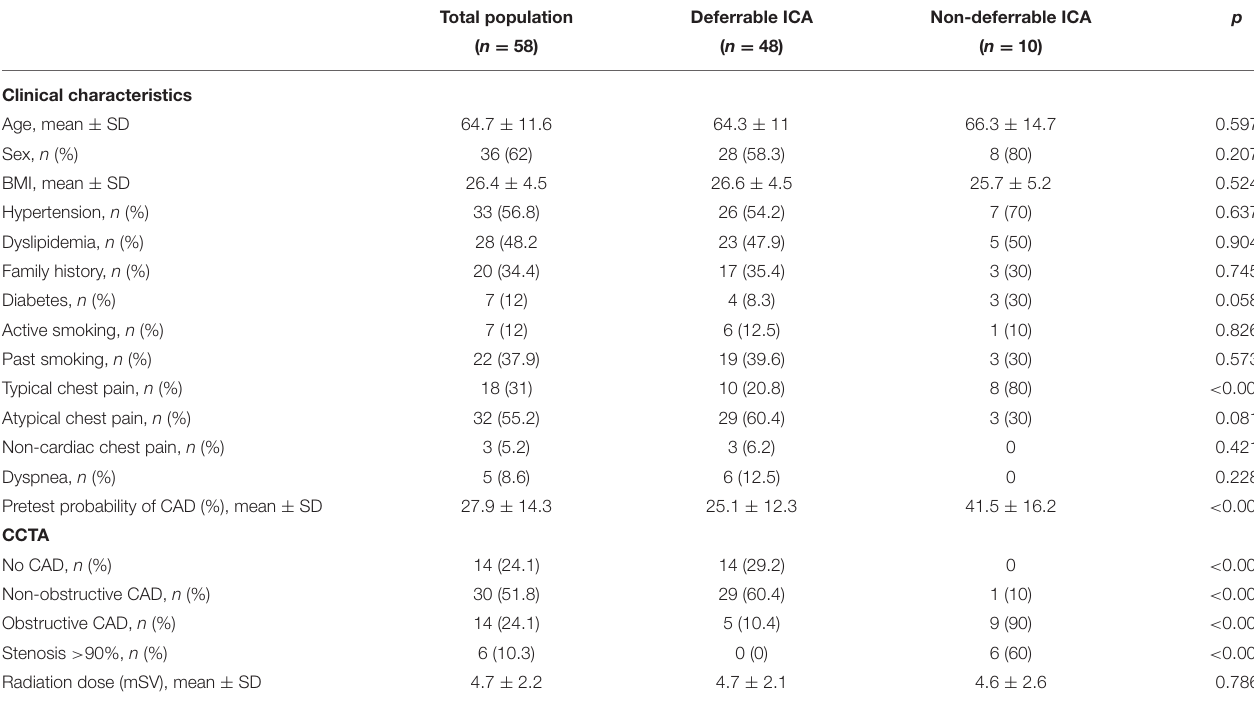
TABLE 1 | Population characteristics.